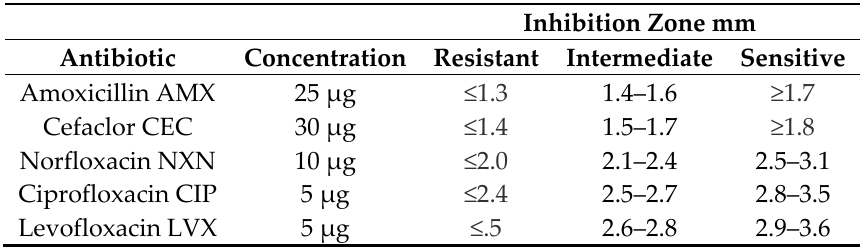
Table 1. Concentration ( μ g) of antibiotics and diameter (mm) of inhibition zones.